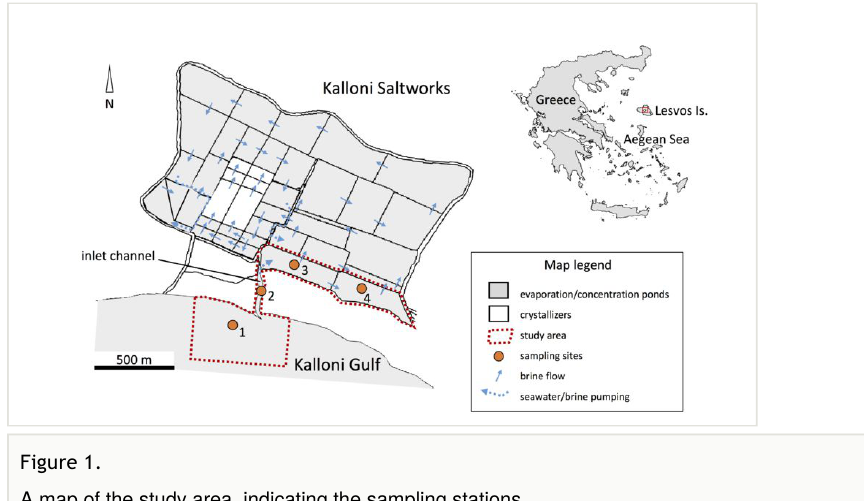
Figure 1. A map of the study area, indicating the sampling Quality control: • Species identi fi cation was reviewed by a molluscan taxonomy expert (Prof. Drosos Koutsoubas) and the species names were checked using the Taxon Match tool of the World Register of Marine Species (http://www.marinespecies.org/ aphia.php?p=match). Dimitra Mavraki and Matina Nikolopoulou of the LifeWatchGreece Core Team assisted in the management of data and the upload of the dataset to the MedOBIS IPT according to the DarwinCore schema (DwC).